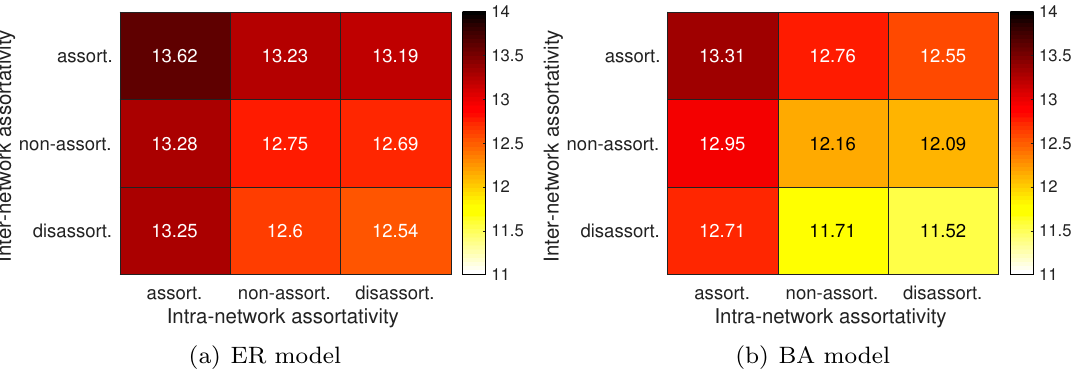
Figure 7. Packet delay with changes in assortativity. Now, in contrast to the GCS, higher values indicate low performance (dark